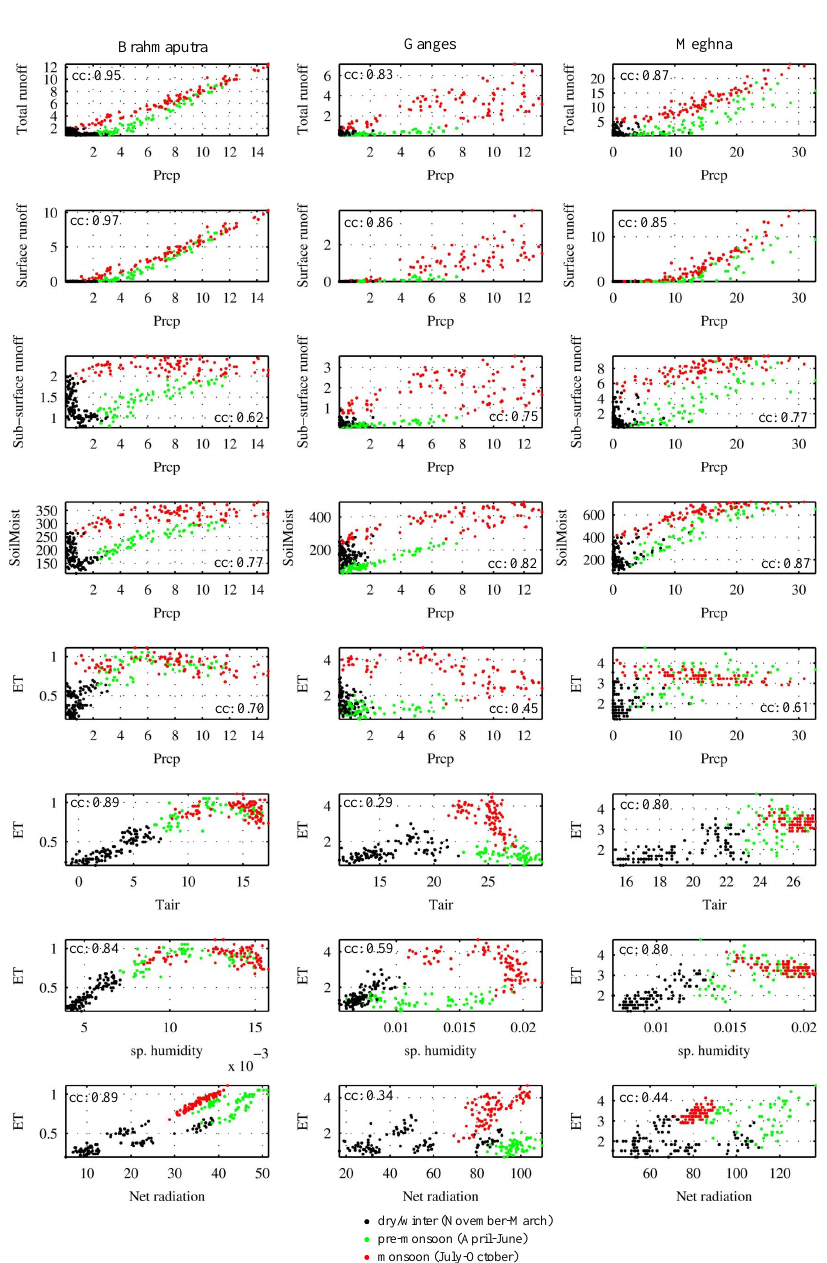
Figure 6. The correlation between the monthly means of meteorological variables (WFD) and that of hydrological variables for the Brahma- putra, Ganges and Meghna basins. Three different colors represent the data in three different seasons. Black: dry/winter (November–March); green: pre-monsoon (April–June); red: monsoon (July–October). The cc for each pair (all three seasons together) is noted at each subplot. The units are millimeters per day for Prcp, ET, and runoff; millimeters for SoilMoist; degrees Celcius for T air ; and watts per square meter for net radiation. All abbreviated terms here are referred to in Table